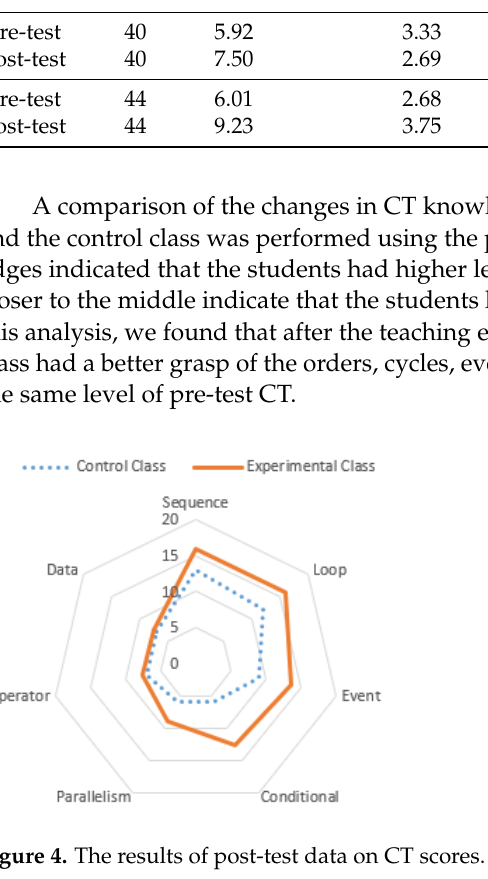
Figure 4. The results of post-test data on CT